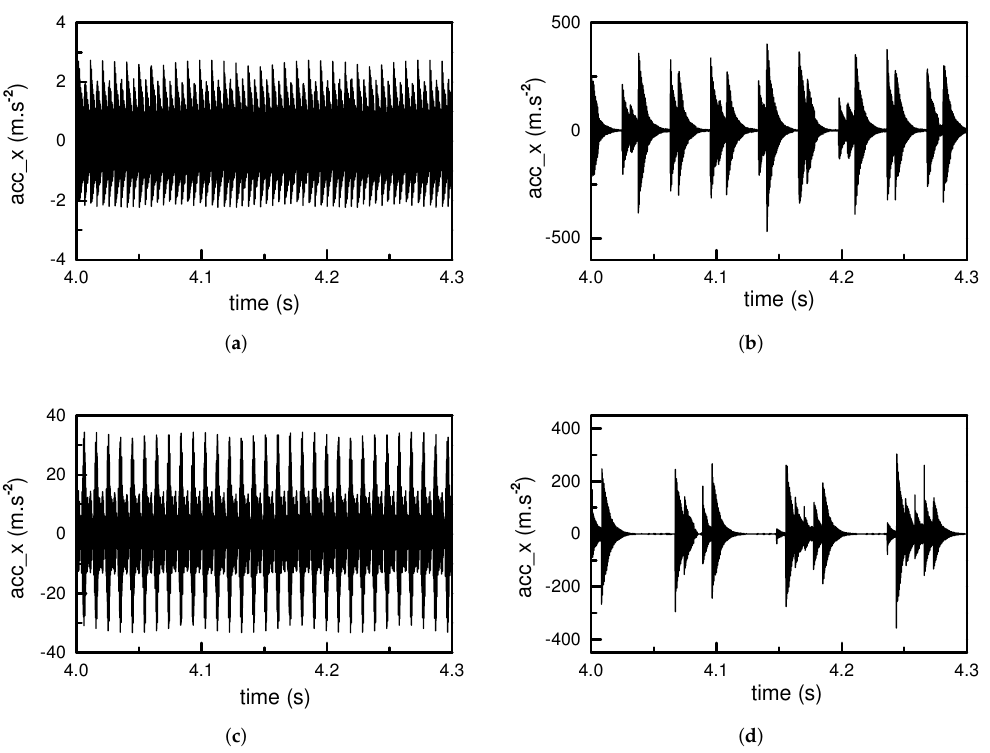
Figure 5. Simulation results with Modelica model. ( a ) Normal bearing, ( b ) Inner race fault, ( c ) Outer race fault, ( d ) Ball